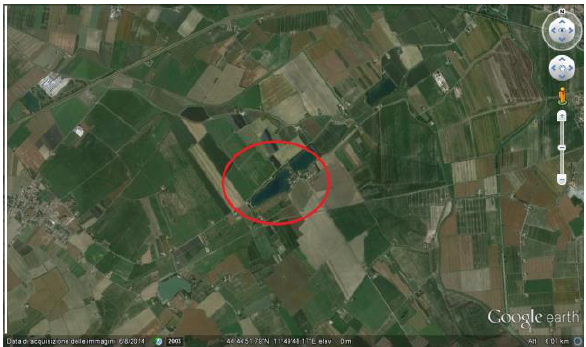
Figure 1. Google Earth satellite imagine: Tramonto Lake, Gambulaga – Portomaggiore (FE),